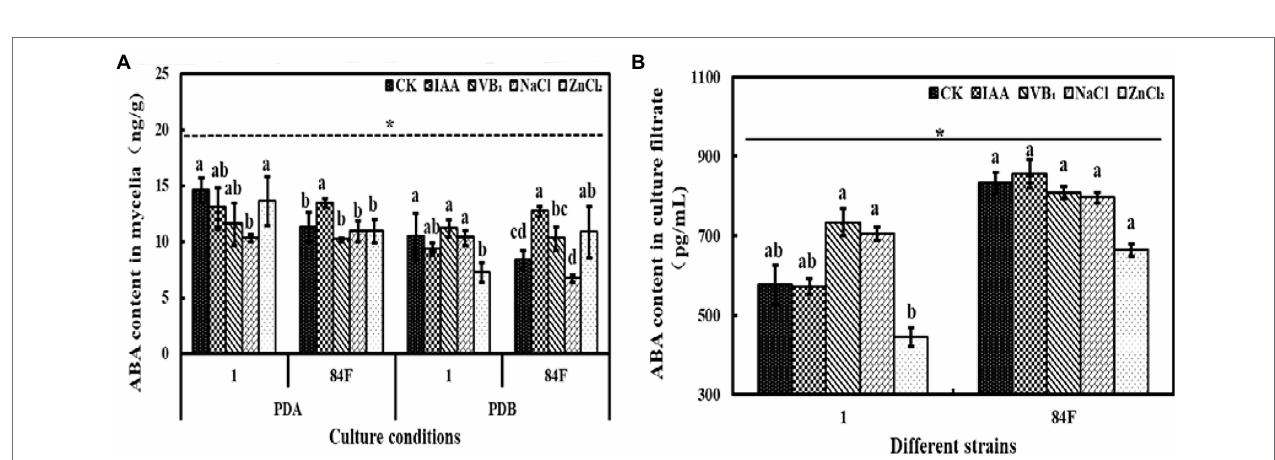
FIGURE 4 | Cytokinins content of E. sinensis under different treatments for 4 weeks. (A) is CTK content in mycelia, and (B) is CTK content in culture filtrate. The same as Figure 1 .